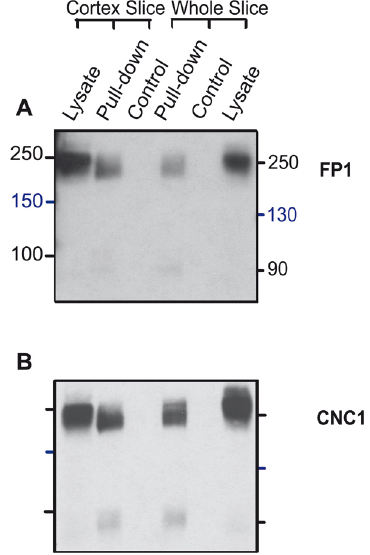
Figure 5. Surface biotinylation labels α 1.2 size forms with 1 apparent M > 200 kDa in rat cortical and forebrain slices. Cortical R and forebrain slices were surface biotinylated and solubilized before pulldown with NeutrAvidin Sepharose, SDS-PAGE in 8% acrylamide gels, and immunoblotting with CNC1 and FP1. Control reflects slices mock treated without Sulfo-NHS-SS-biotin to demonstrate specificity of pulldown. Twenty μL lysate was also directly loaded for comparison.